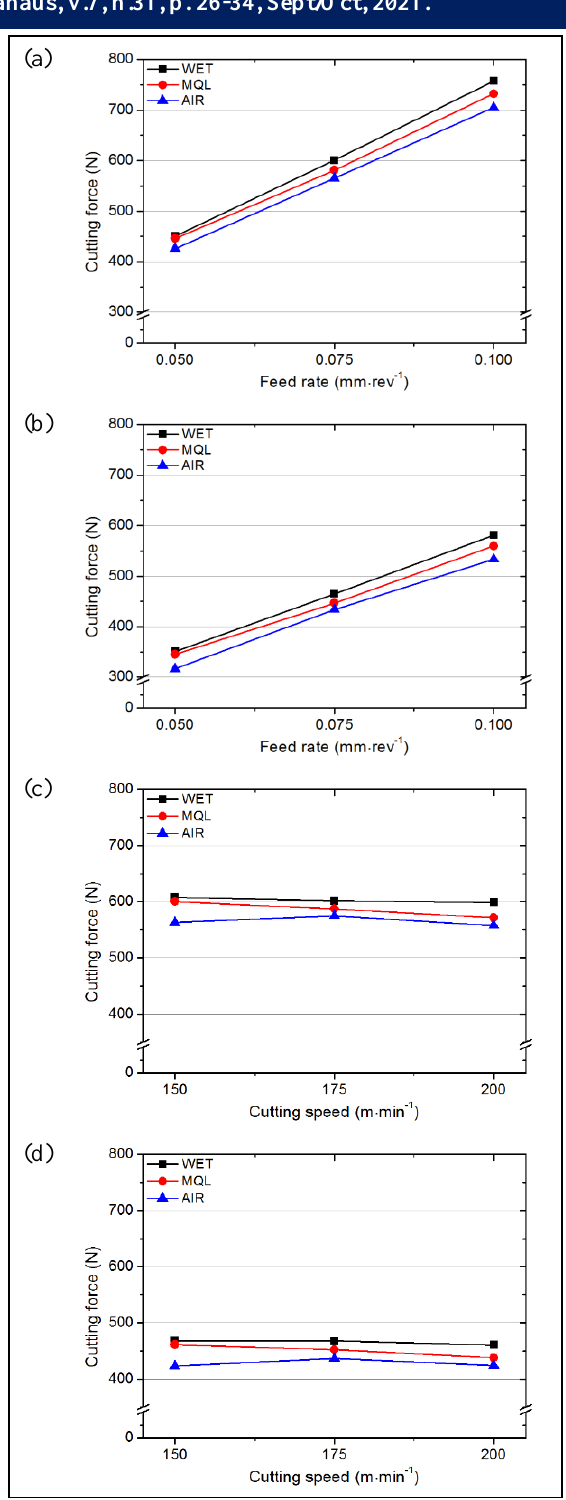
Figure 5: Average cutting force ( F y ) as a function of: (a) feed rate for SG; (b) feed rate for PG; (c) cutting speed for SG; (d) cutting speed for